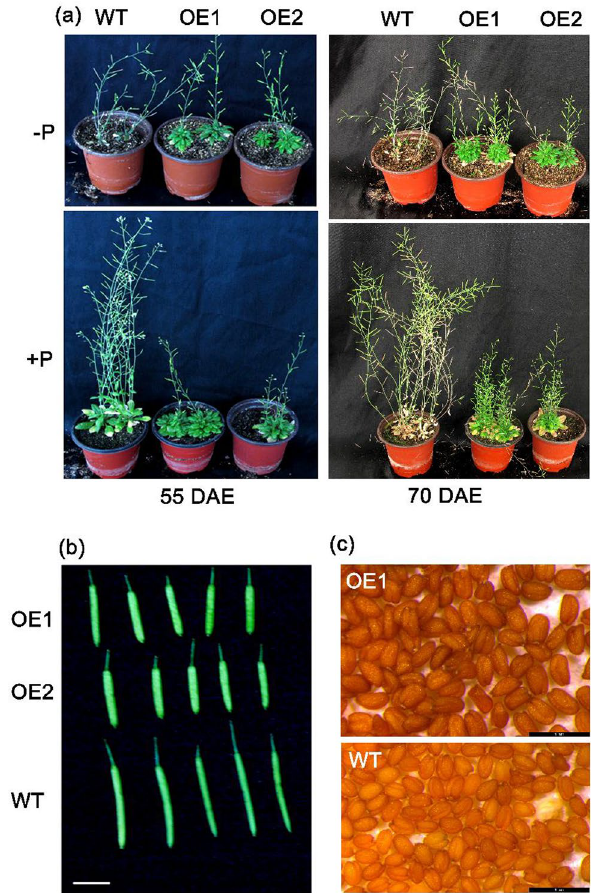
Figure 4. Phenotype of adult Arabidopsis plants grown under P-sufficient and P-deficient conditions. ( a ) The morphological phenotype of GmmiR156b overexpressing lines (OE1, OE2) and the wild type (WT) on 55 days and 70 days after emergence (DAE) under + P (P sufficient) and − P (P deficient conditions). ( b ) Siliques of WT and OE lines, bar = 1 cm. ( c ) Mature seeds of WT and OE lines, bar = 1